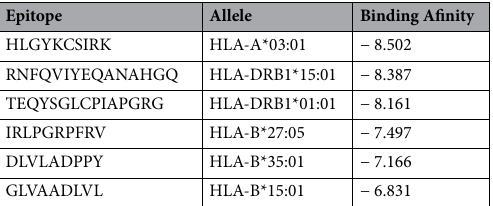
Table 4. Binding Affinity between the selected epitopes and their corresponding MHC alleles in (Kcal/mol).